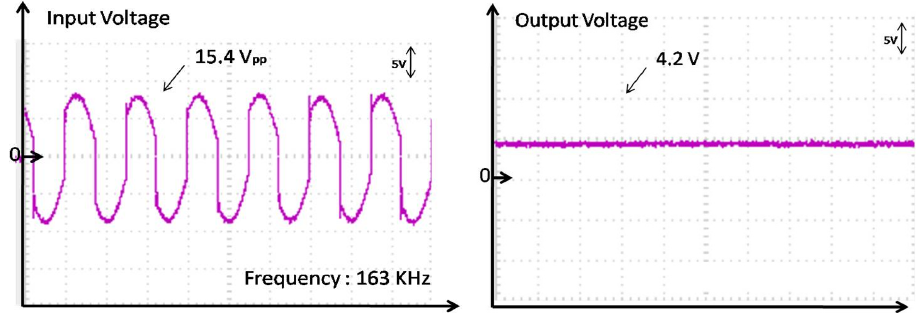
Figure 12. Voltage signal on the transmitter circuit ( Left ) and output voltage on the battery ( Right ).